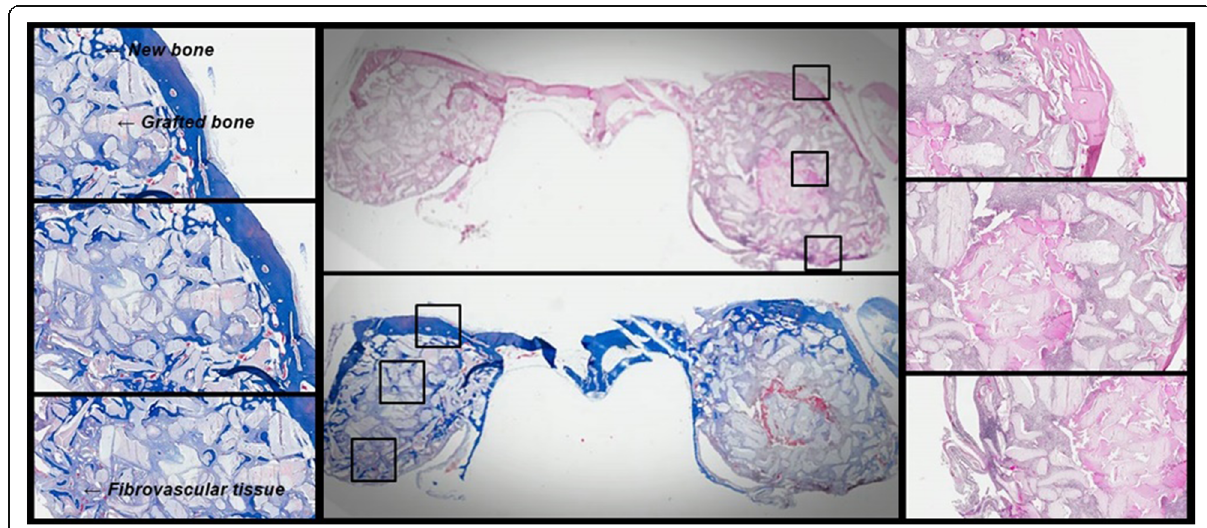
Fig. 3 Photomicrograph shows grafted region after 12 weeks. a Masson ’ s trichrome stain × 100. b Overall view. c Hematoxylin and eosin stain × 100. G 1, group 1, Bio-Oss®; G 2, group 2, Bio-Oss® mixed with Tisseel®